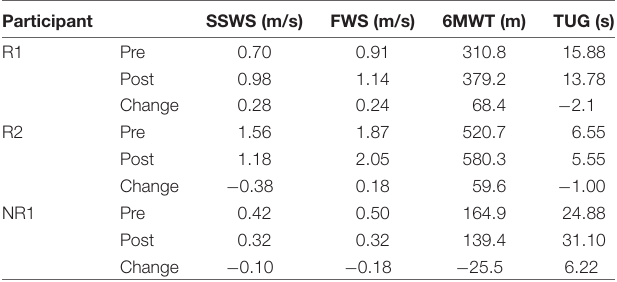
TABLE 2 | Clinical measures of gait before and after FastFES rehabilitation.